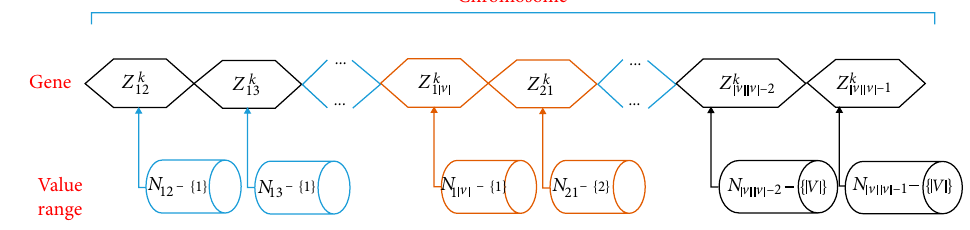
Figure 3: Encoding of genetic